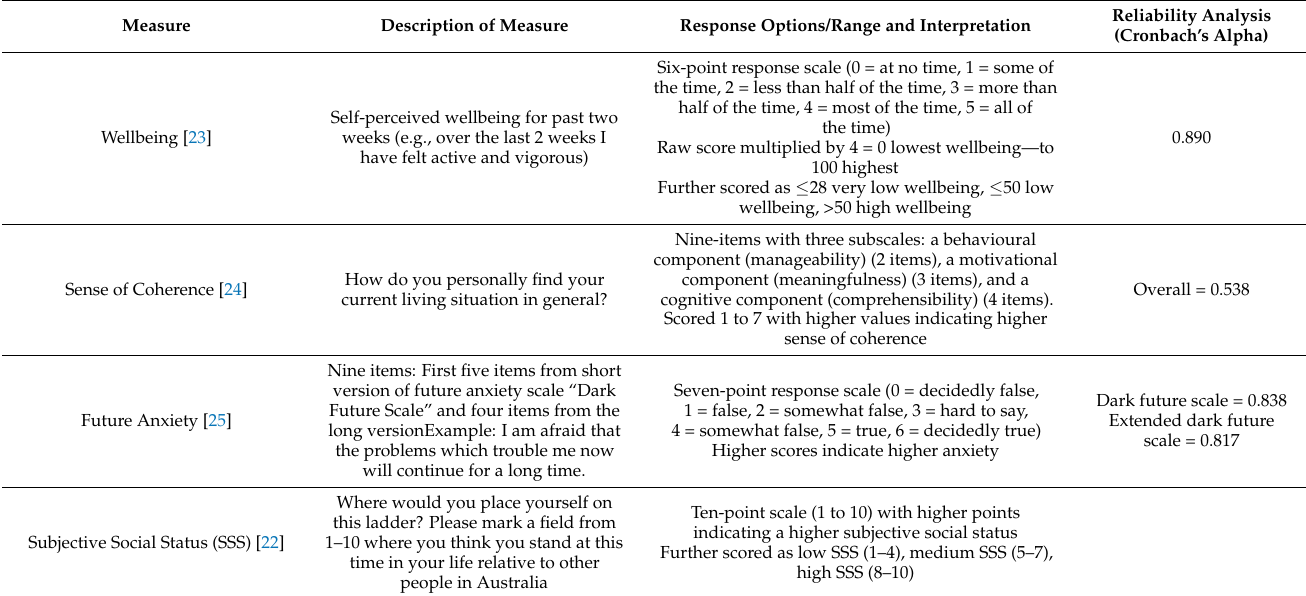
Table 1. Detailed description of the measures